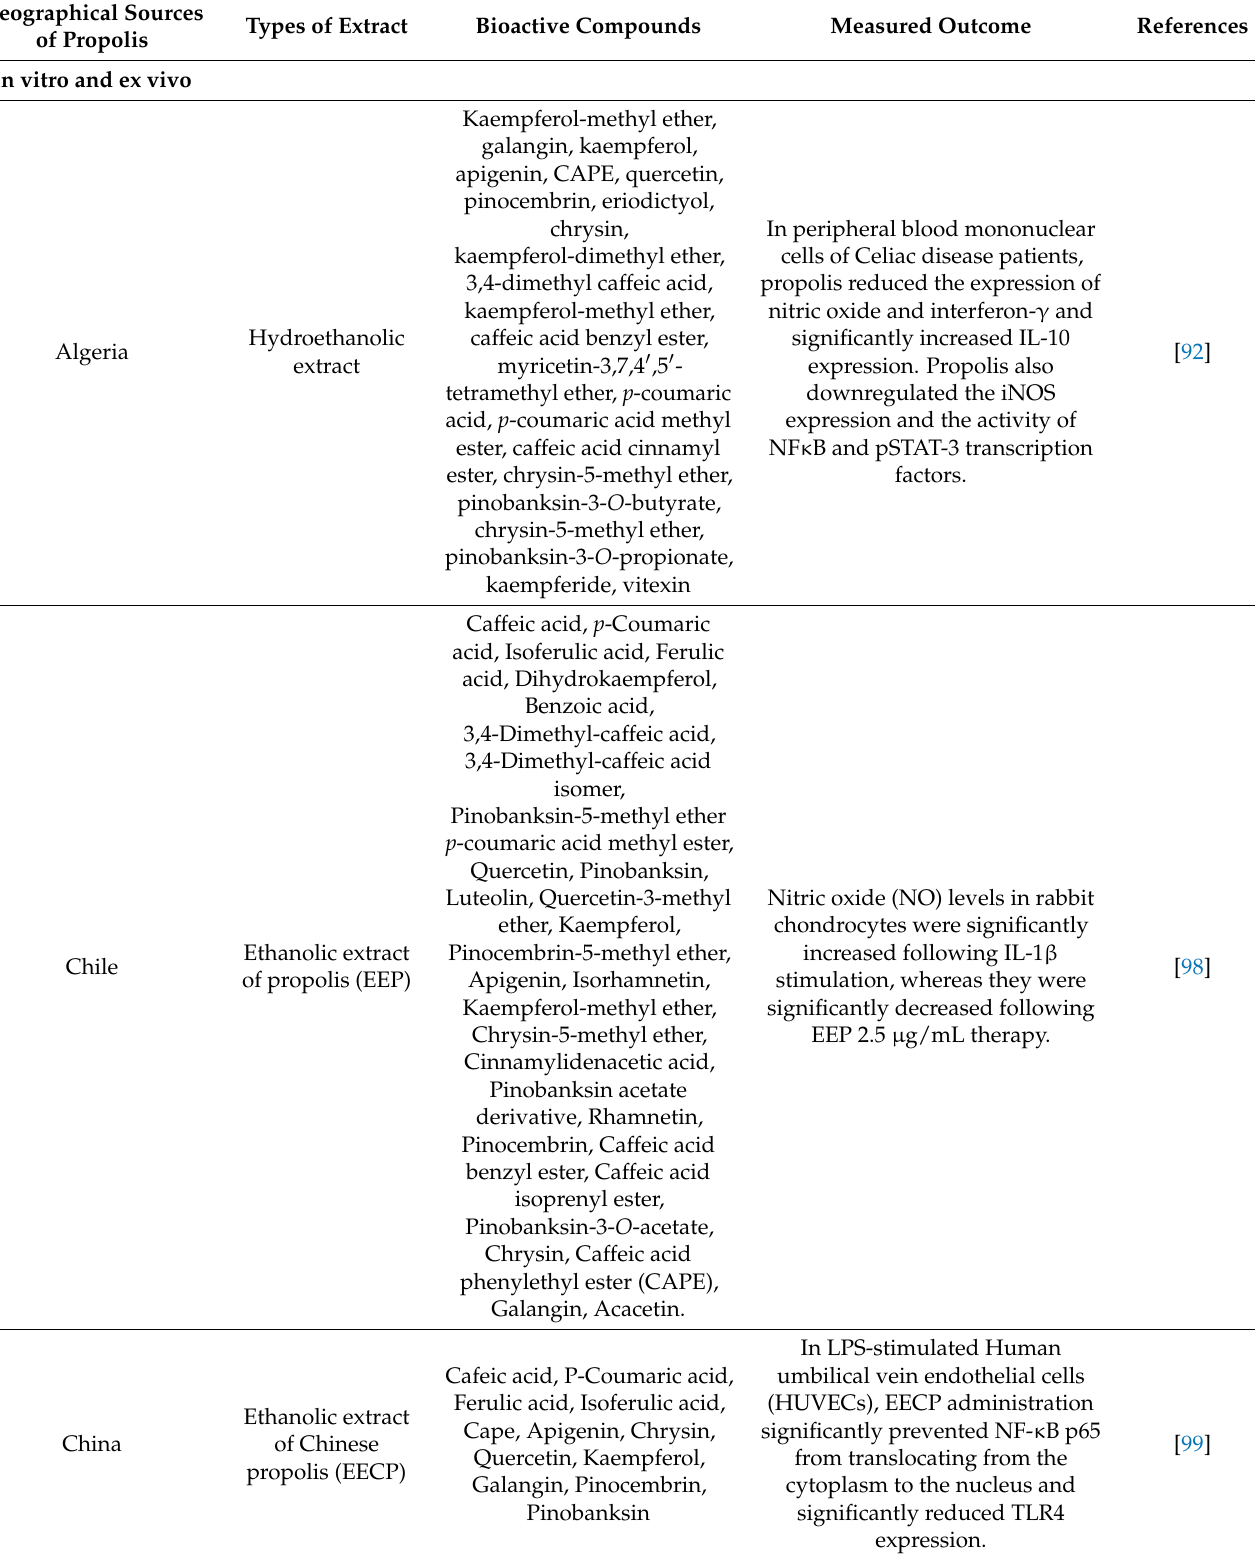
Table 5. Anti-inflammatory properties of propolis inorgan toxicity and